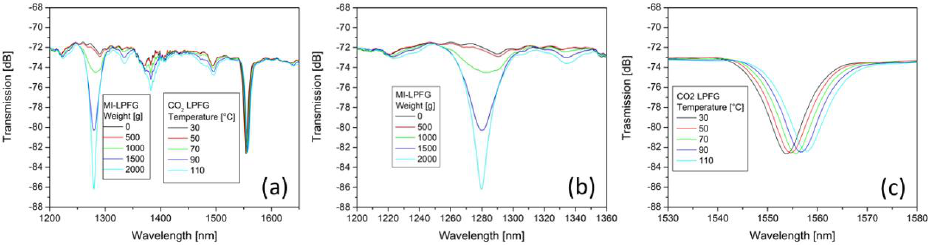
Figure 7. The transmission spectrum of ( a ) multiplexed LPFGs, ( b ) MI-LPFG, ( c ) CO 2 LPFG versus applied transverse load on MI-LPFG and temperature on the CO 2 LPFG, simultaneously.